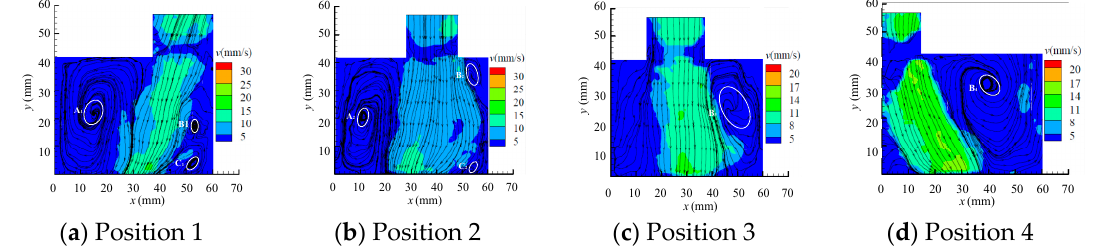
Figure 13. Velocity contours and streamlines with a pump inlet flow of 750 mL/min.